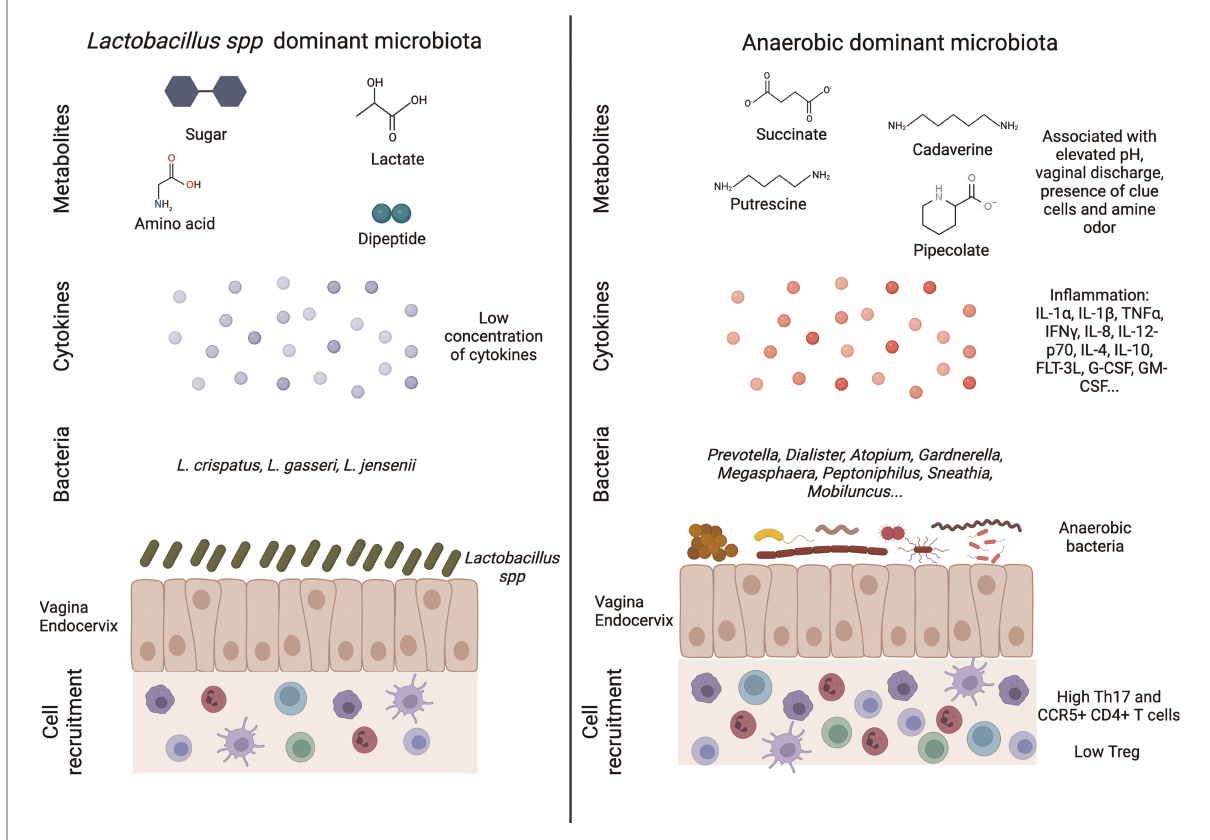
FIGURE 1 Vaginal microbiota and female reproductive tract in fl ammation. An eubiotic vaginal microbiota is dominated by Lactobacillus spp. that can produce different metabolites such as sugar, lactate, amino acid and dipeptide. This environment is associated with a low in fl ammation including cytokine production and immune cells recruitment ( left panel ). On the contrary, a more diverse vaginal microbiota (low Lactobacillus spp. and high anaerobic bacteria abundances) is associated with an increased in fl ammation. The microbial environment leads to the production of metabolites linked to vaginal discomfort such as vaginal discharges or amine odor. In this context, higher production of cytokines and recruitment of T cells (Th17 and CCR5+ CD4+ T cells) are detected ( right panel ). Created with